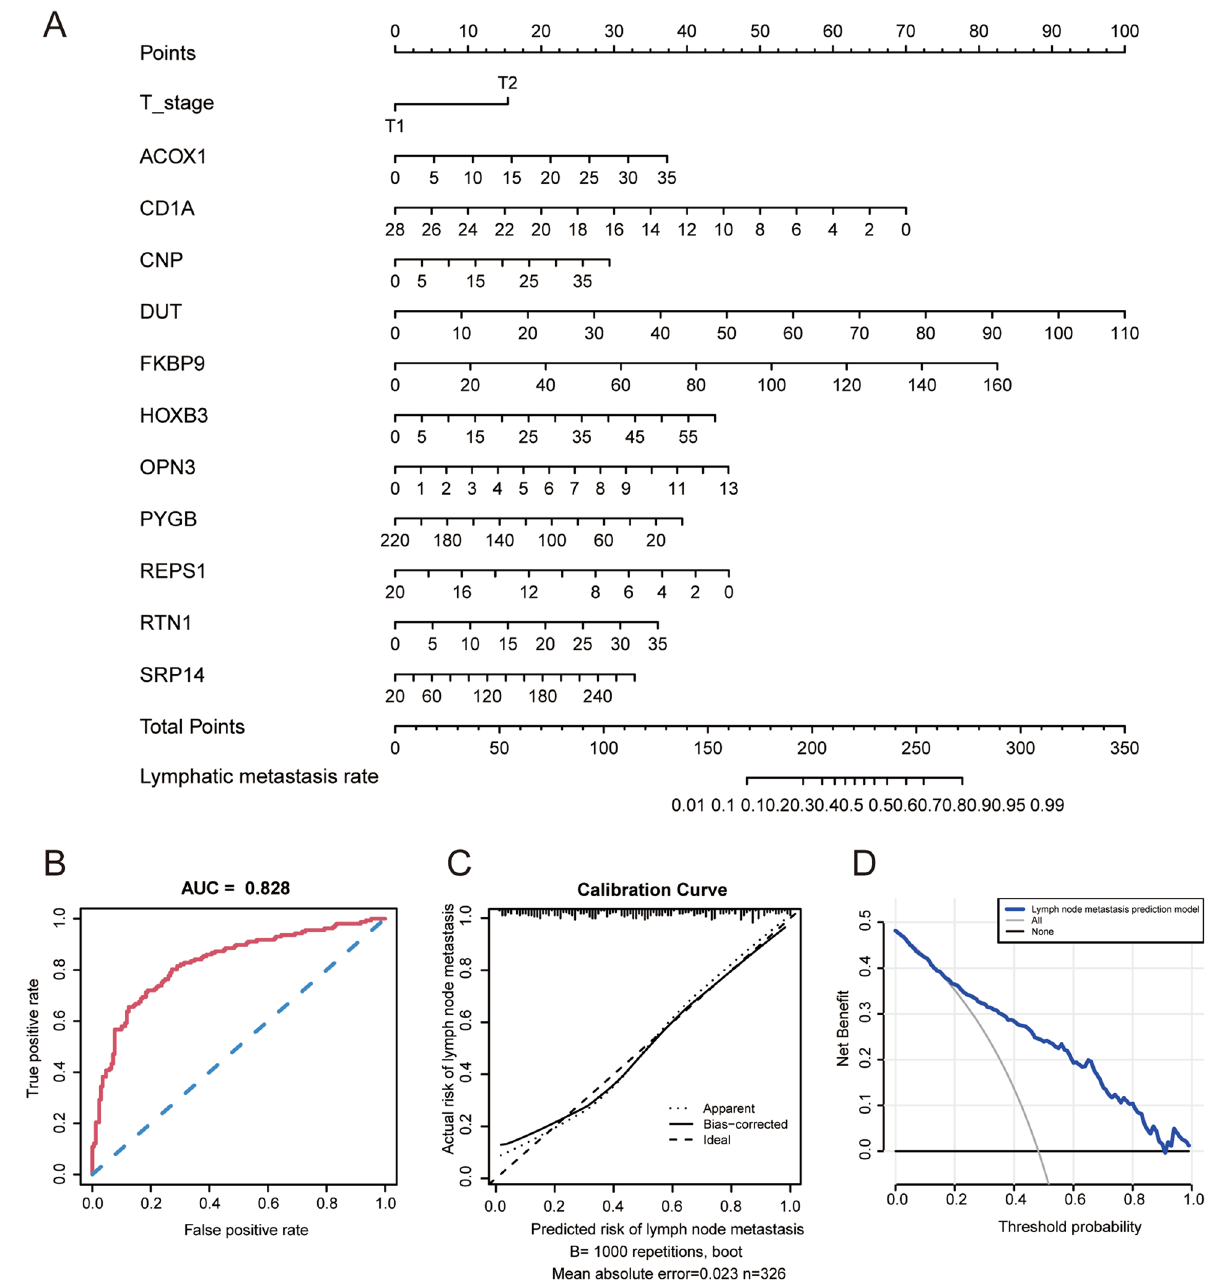
Figure 2. Efficacy of the risk prediction model in T1-2 invasive breast cancer. ( A ) Nomogram for the model; ( B – D ) ROC curve, calibration plot and decision curve analysis of the nomogram in predicting lymph node metastasis in the TCGA training